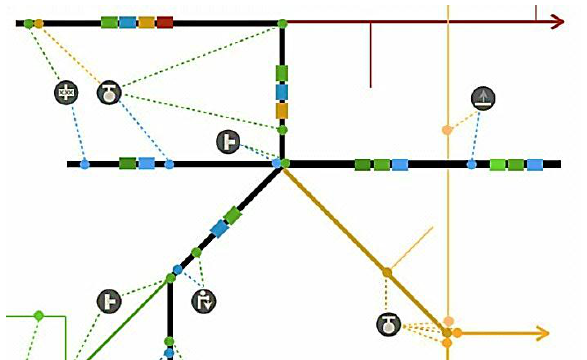
Figure 10. Proposed visualization for schematic abstracted lines and symbols with design elements, color code, and dimensions Moreover, to pronounce their cognition, aggregates were extended in their thickness and colorized with black, ensuring the highest level of graphical dominance in order to catch the disaster managers’ attention (Figure 10). It is important to preserve information about supplier and hierarchy, so color- coded box annotations at defined intervals were added to the aggregated lines (Figure 10). Finally, to ensure the safe and quick identification of these annotations, they are designed as 8pt. thick and 12pt. long rectangles. Smaller dimensions certainly influence the color impression of each box by surrounding objects, as described by (Steinrücken, 2009). The order of objects can be determined, when rotating each box- group with 90° at its ride hand side anchor point. Line crossings and branches can be visualized implicitly.